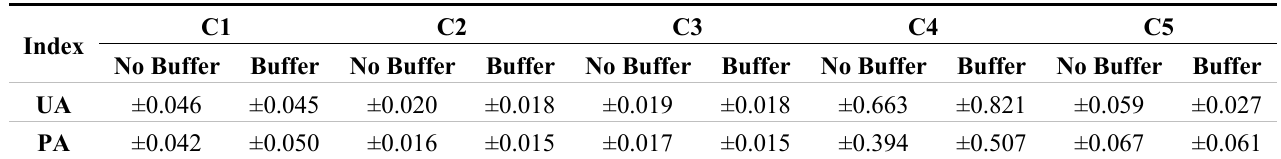
Figure 5. Comparison between GlobeLand30 2000 and DUSAF1.1 (I reclassification): per-class statistics referred to 30 m resolution input datasets. C1: artificial surfaces, C2: agricultural areas, C3: forest and semi natural areas, C4: wetlands, C5: water bodies. Table 5. Comparison between GlobeLand30 2000 and DUSAF1.1 (I reclassification): per-classes confidence intervals at 95% probability calculated for user (UA) and producer accuracies (PA); data refer to 30 m resolution input